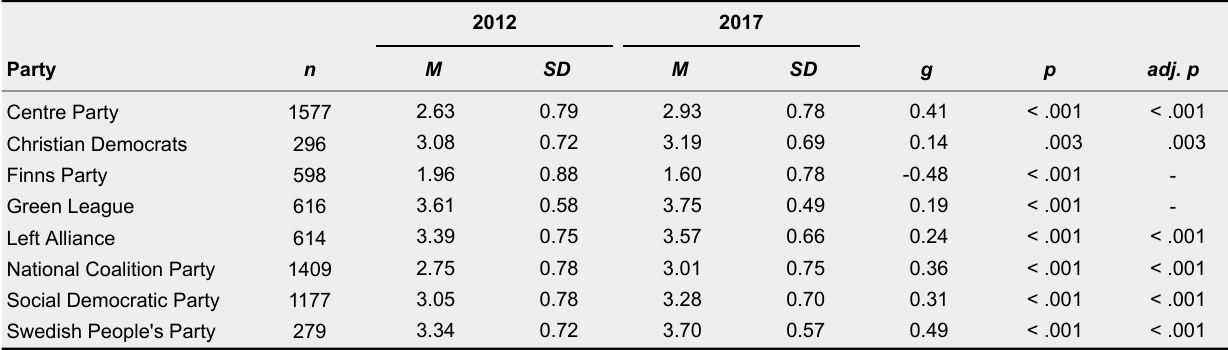
Party-Specific Descriptive Statistics and Standardized Mean Differences in Acceptance of Refugees